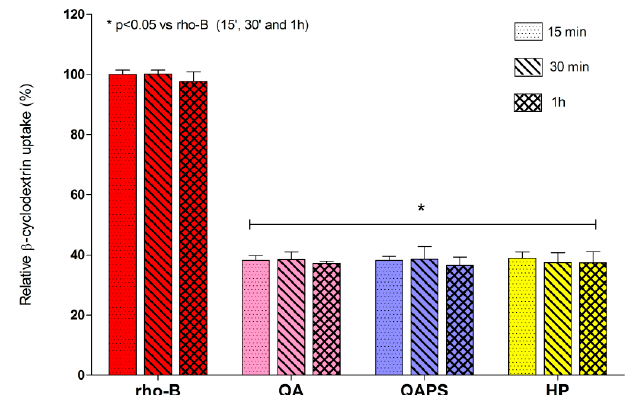
Figure 4. Relative beta-cyclodextrin uptake in CACO-2 cells. Evaluation of the intracellular fluorescence in CACO-2 cells after exposure to RBITC-HP, RBITC-QA and RBITC-QAPS (5 µ M) for 15, 30 and 60 min. Data are reported as mean ± SD ( n = 3). * p < 0.05 vs. rho-B 0.5 µ M at 15, 30 and 60 min (ANOVA test).